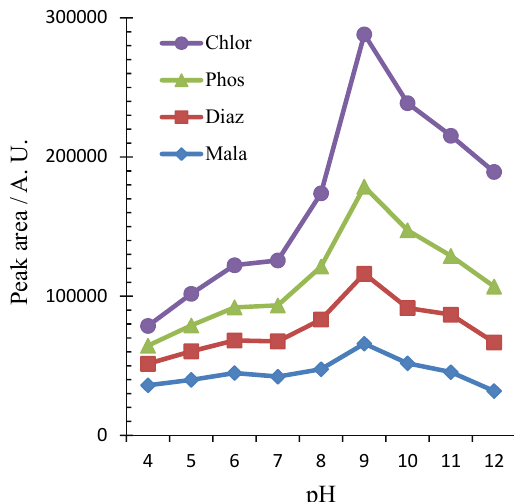
Fig. 3: E ffect of solution pH on the extraction efficiency of OPPs by GQDs/ESM nano-sorbent. Conditions: adsorbent amount: 150 mg; sample volume: 150 mL; concentrations of each analyte: 100 ng mL −1 ; flow rate: 2 mL min −1 ; desorption